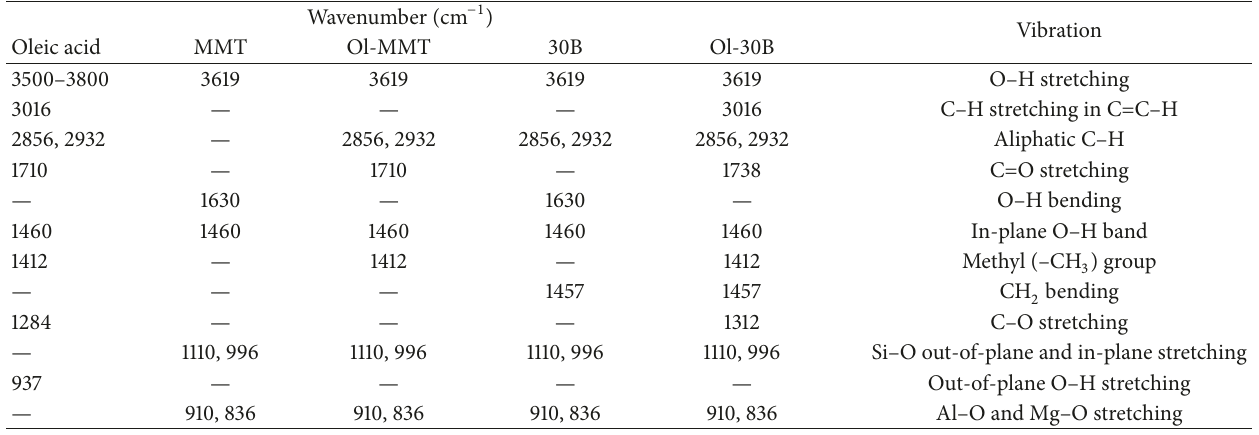
Table 1: IR bands of oleic acid, MMT, 30B, ol-MMT, and ol-30B.